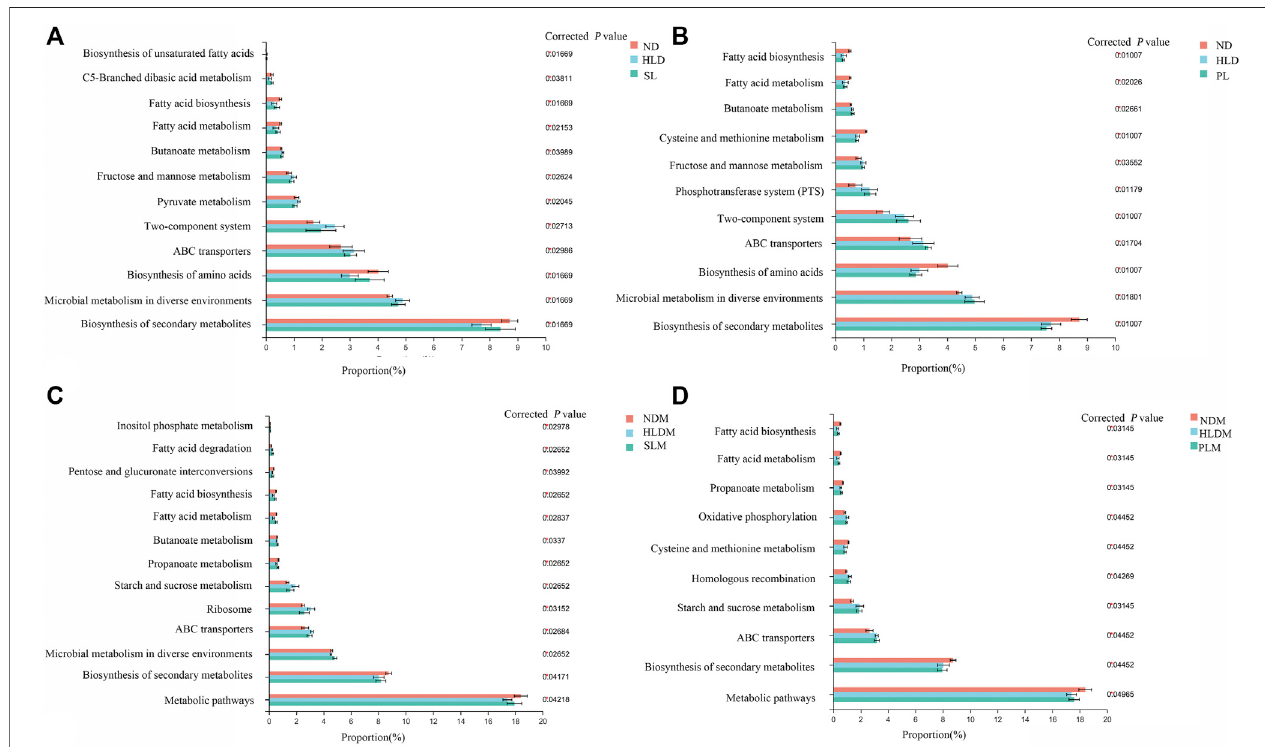
FIGURE9| FunctionalpredictionofalteredluminalandmucosalmicrobiotabasedonKEGGpathways (A) Atotaloftwelvesigni fi cantlyrecoveredKEGGpathways by SL treatment in the luminal microbiota of HLD rats (B) Few recovered KEGG pathways by polysaccharide treatment in luminal microbiota (C) A total of thirtheen signi fi cantlyrecoveredKEGGpathwaysbySLtreatmentinmucosalmicrobiotaofHLDrats (D) Atotalofeightsigni fi cantlyrecoveredKEGGpathwaysbyPLtreatmentin the mucosal microbiota of HLD rats. The results were determined by a nonparametric factorial Kruskal – Wallis (KW) sum-rank test. Data are represented as the mean ± SEM (n = 6-8 per